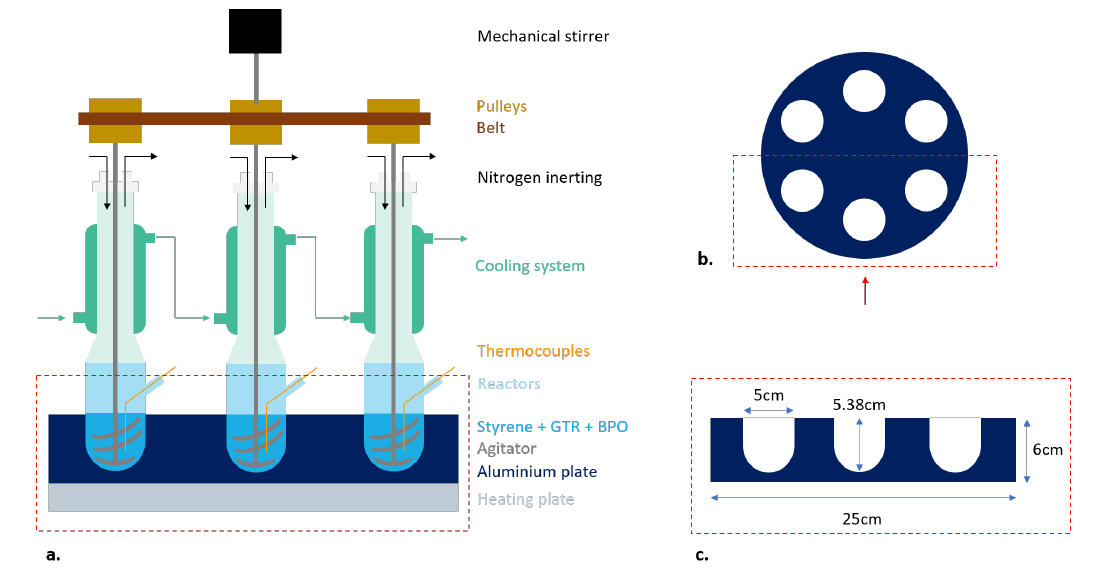
Figure 1. ( a ) Side view of the experimental medium-sized system. ( b ) Top view of the aluminum plate. ( c ) Side view of the aluminum plate from the red